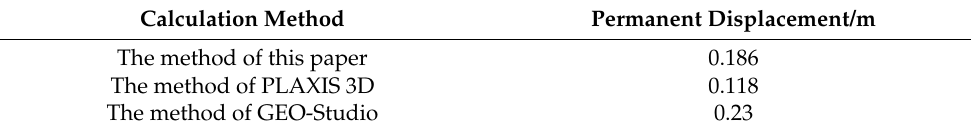
Table 4. Comparison of permanent displacement of sliding soil.